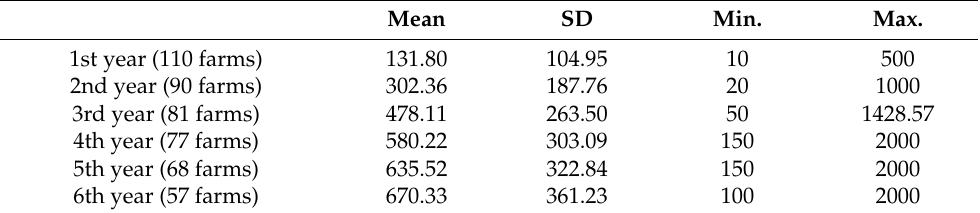
Table 2. Summary statistics of the amount of harvested saffron flowers (kg/ha) in the first six years. Mean SD Min.